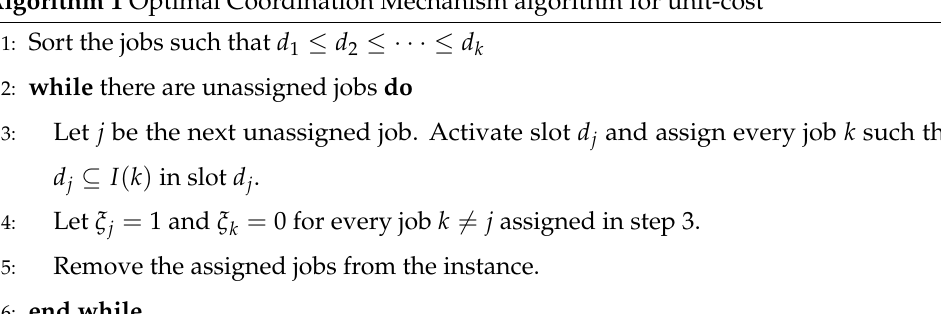
Algorithm 1 Optimal Coordination Mechanism algorithm for